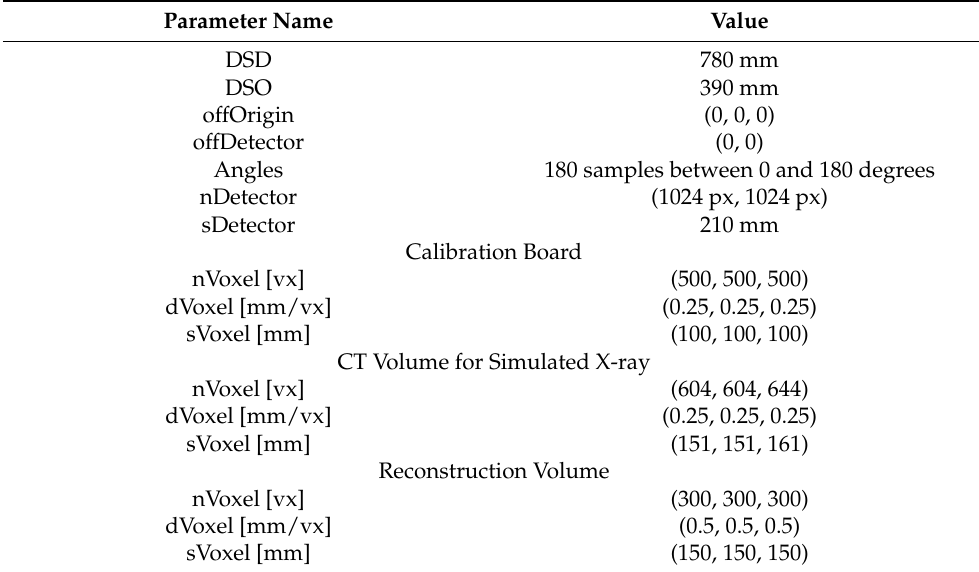
Table 2. Values of some common parameters used in the simulation.